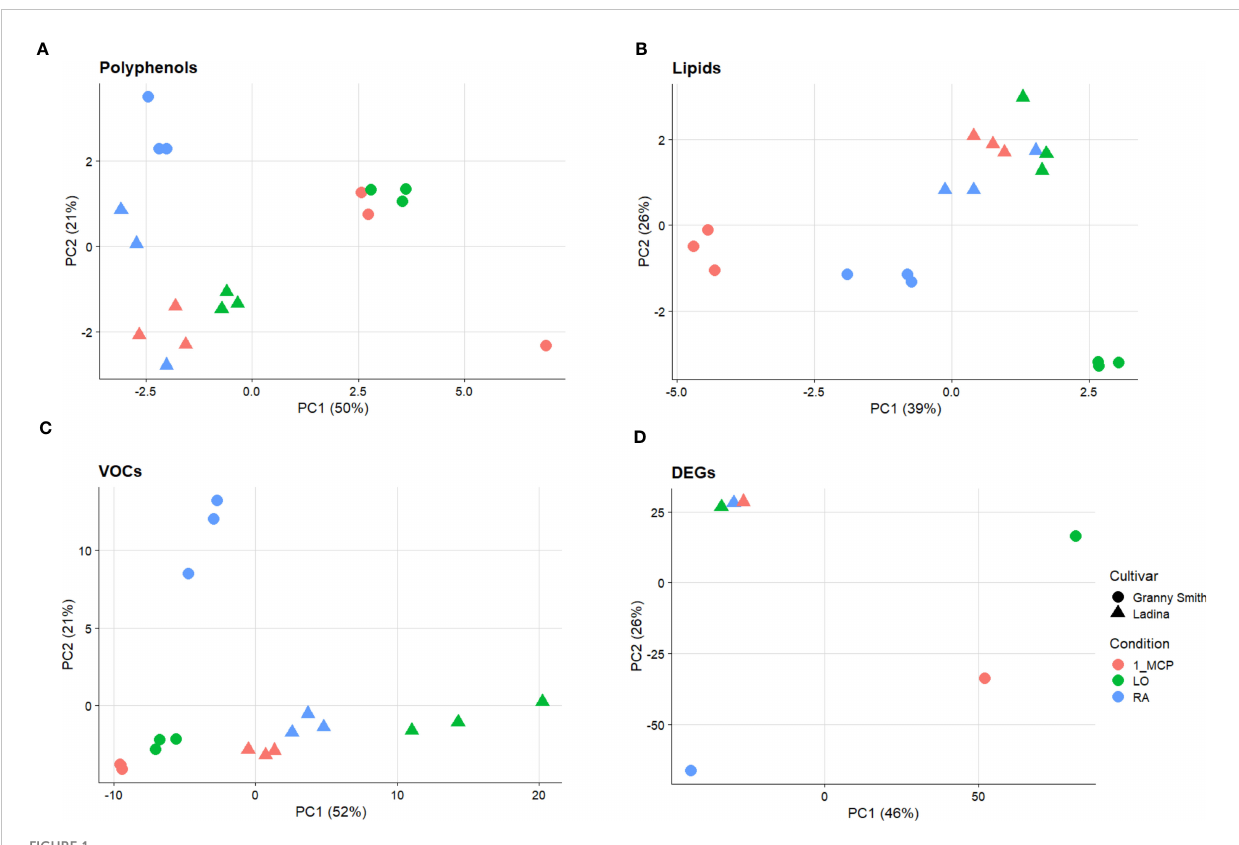
FIGURE 1 Principal Component Analysis (PCA) performed on polyphenols (A) , lipids (B) , volatile organic compounds (VOCs) (C) and differentially expressed genes (DEGs) (D) in ‘ Granny Smith ’ ( ● ) and ‘ Ladina ’ ( ▲ ) apple cultivars. RA= Regular Atmosphere ( ● ); 1-MCP= Regular Atmosphere + 1-MCP treatment ( ● ); LO= Low Oxygen condition ( ● ). In the PCA of panel (A – C) the distribution of the three biological replicates is